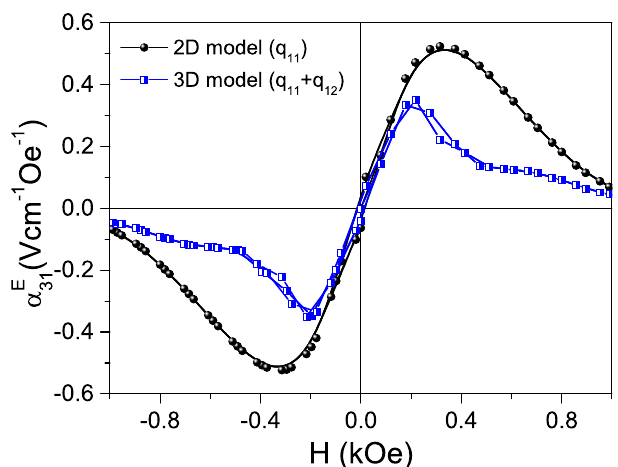
Figure 12. Transverse ME coefficient α E as a function of the bias magnetic field (H), simulated using 31 2D and 3D models for the three-layer CFM25/L4.0Ta15/CFM25 with 2R/t